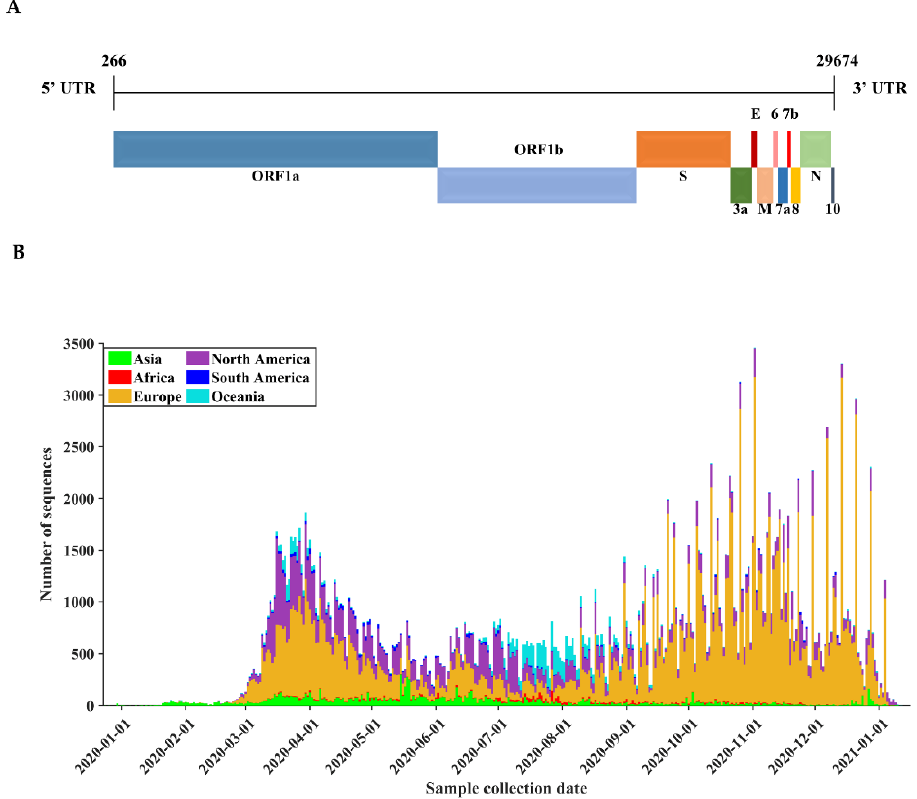
Figure 1. Severe acute respiratory syndrome coronavirus 2 (SARS-CoV-2) genome organization and the distribution of the SARS-CoV-2 genome sequence used in this study. (A) Genomic architecture of SARS-CoV-2 based on the reference sequence (Wuhan-Hu-1, NCBI accession NC_045512). (B) The temporal and geographic distribution of all sequences. All temporal analyses were based on the date of sequence collection.